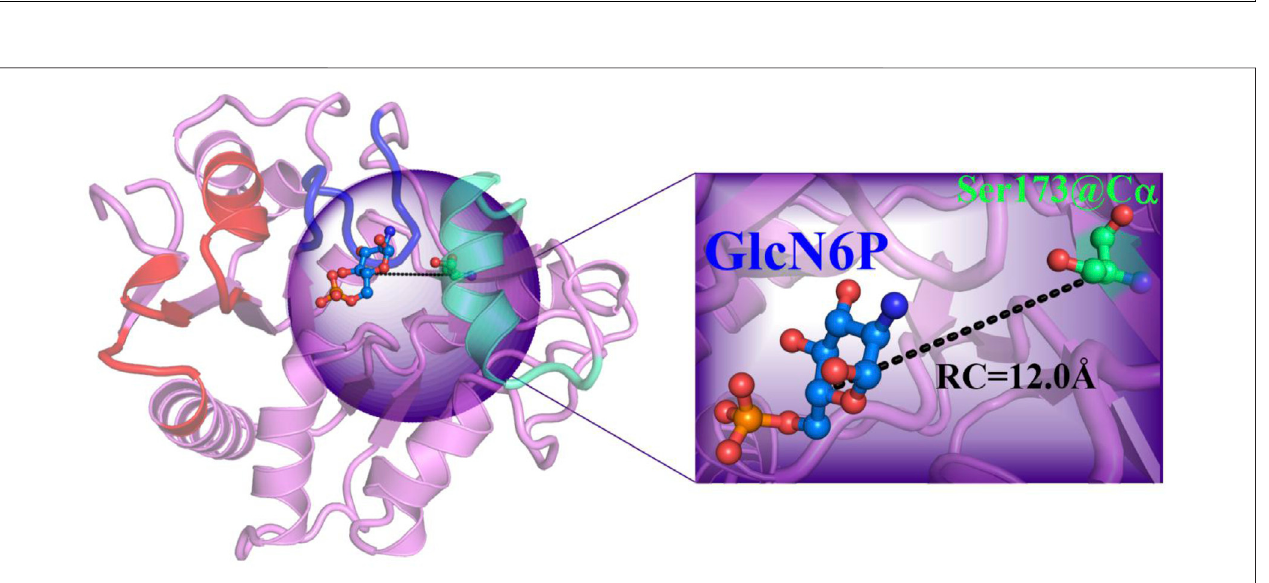
FIGURE 6 | Reaction coordinate de fi nition in umbrella sampling for the most favorable mode of extraction in the P1 direction.